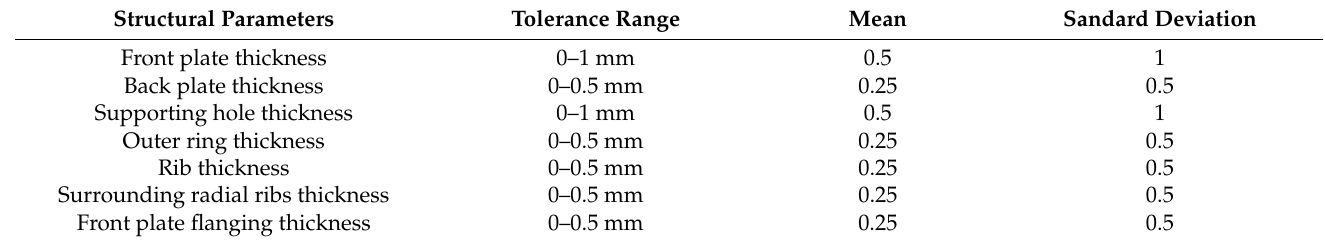
Figure 7. Integrated simulation link based on Monte Carlo. Table 3. The result of Monte Carlo simulation. Gravity-RMS/nm